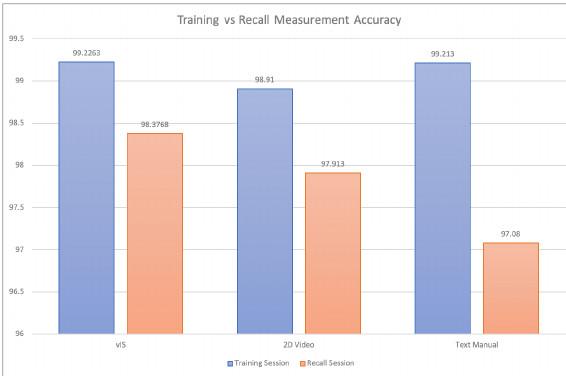
Figure 3. Training vs. Recall Measurement